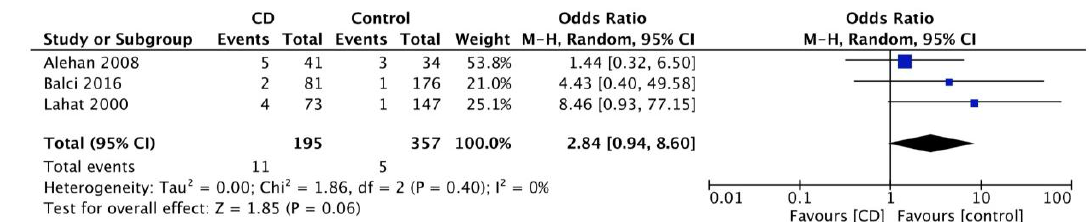
Figure 6. Pooled mean prevalence of serologically confirmed gluten sensitivity in children with idiopathic migraine.